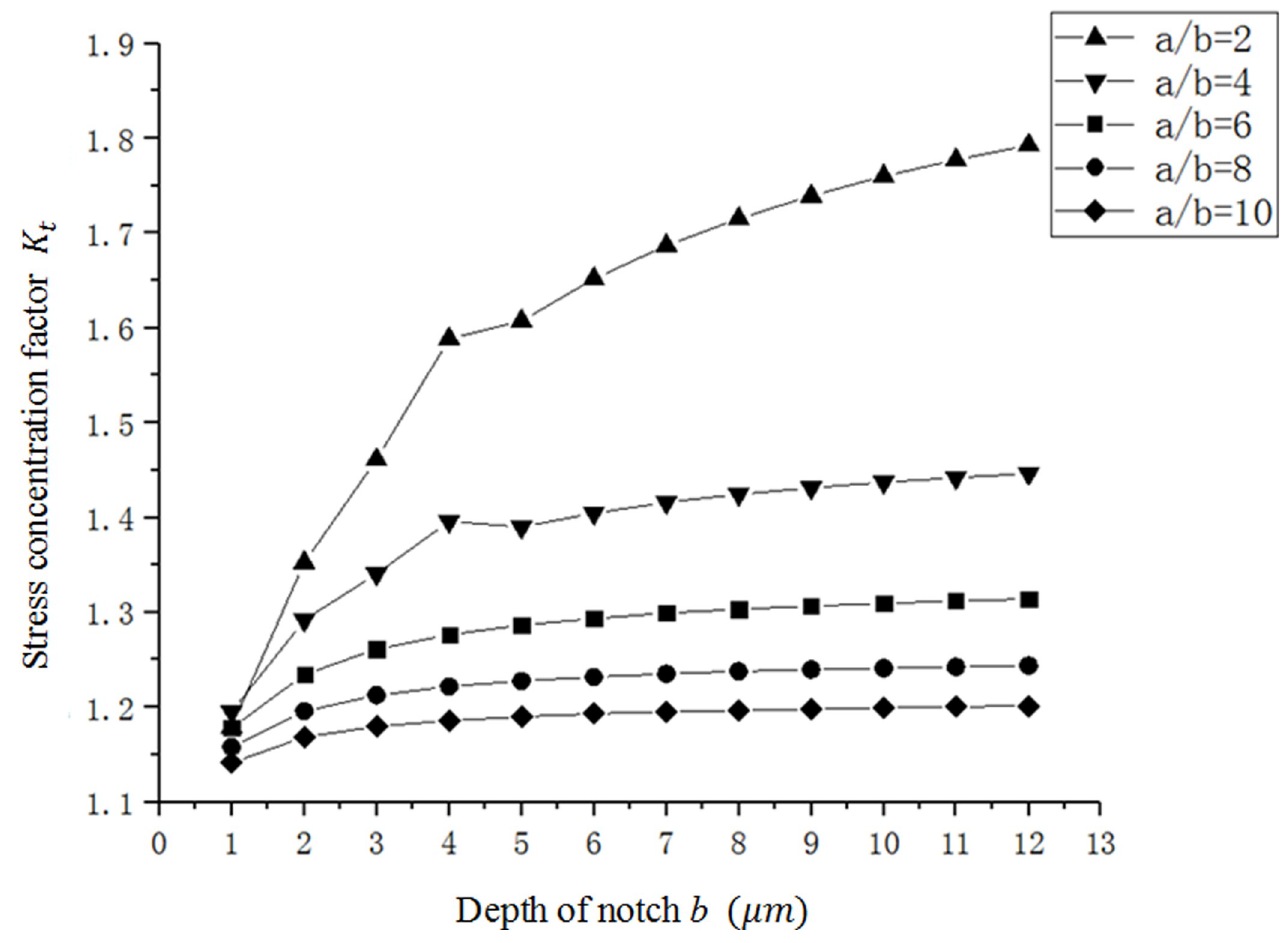
Fig 9. The relation curve between K t and b in a single micro-notch.